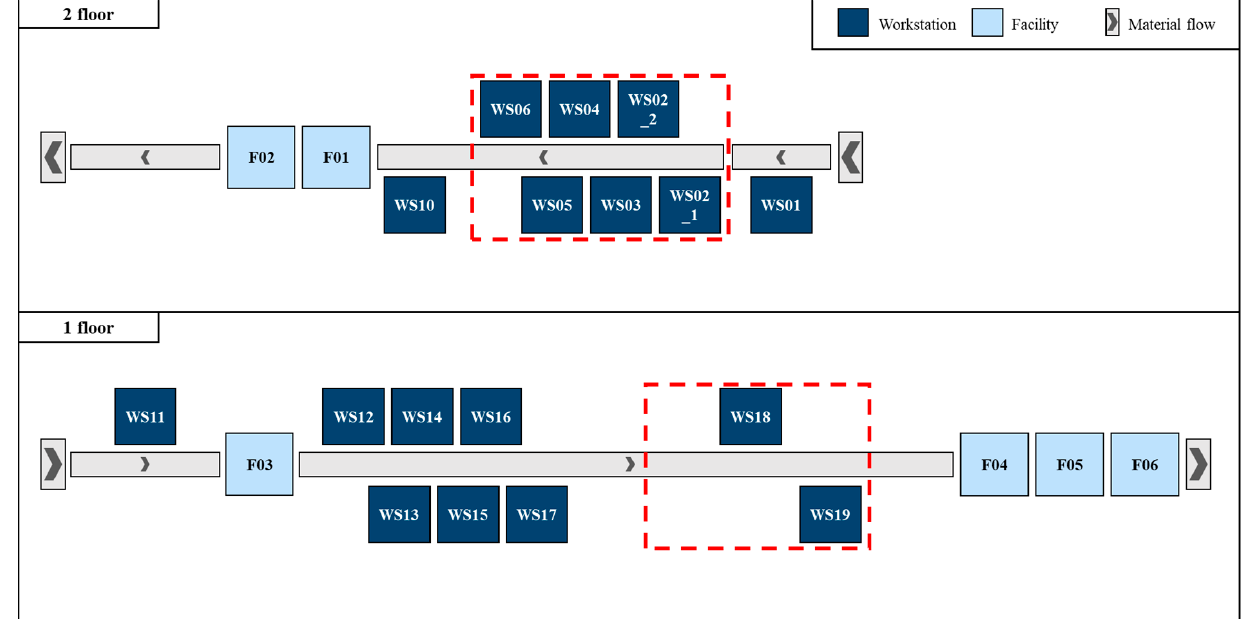
Figure 6. Layout image before optimization.